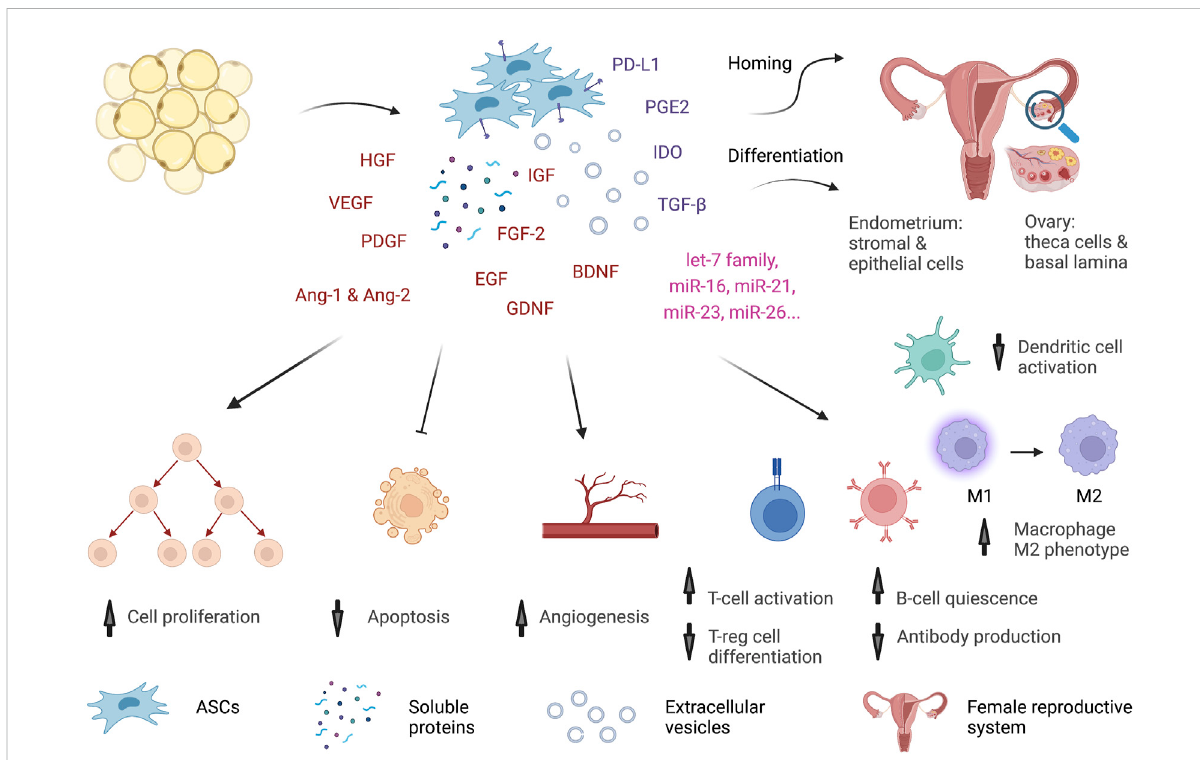
FIGURE 2 Potential mechanisms of ASCs. ASCs might act through multiple mechanisms to improve the functions of the female reproductive system. The cells can home and be retained in the reproductive tract for a short time. In the ovary, they differentiate into theca cells and form basal lamina to support oocyte development. In the uterus, ASCs give rise to stromal and epithelial cells of the endometrium. Similar to MSCs from other tissue sources, ASCs exhibit a profound secretome and immune regulation activity. The cells secrete many growth factors, cytokines, and miRNAs in the form of both soluble proteins and extracellular vesicles. Growth factors, such as HGF, VEGF, IGF, FGF-2, EGF, GFNF, and BDNF, trigger cell proliferation,inhibitapoptosis, and promote wound healing inmany organs,includingthereproductive system. VEGF, PDGF, HGF, Ang-1 andAng-2 orchestrate angiogenesis. Moreover, ASCs produce many strong anti-in fl ammatory factors, such as PGE2, IDO, TGF- β , and PD-L1, to regulate immune cells. ASCs inhibit Th1-cell proliferation and promote regulatory T-cell differentiation. They induce quiescence of B cells and alter antibody production.They shift macrophages from aproin fl ammatoryM1 to an anti-in fl ammatoryM2 phenotype and interferewith dendriticcell maturation. Hence, ASCs might reverse the aging process by restoring reproductive organ functions and increasing estradiol levels, modulating the immune system, and reducing in fl